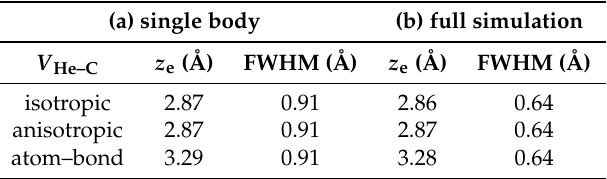
Table 3. The equilibrium separation of 4 He atom(s) from the graphene plane z e , and the full width at half maximum (FWHM) of the associated distribution. Both single-body and full-simulation results are reported.